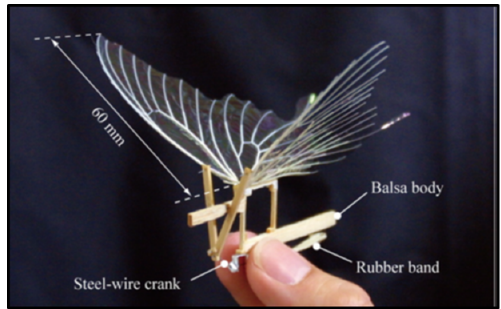
Figure 1. Artificial butterfly driven by machinery.